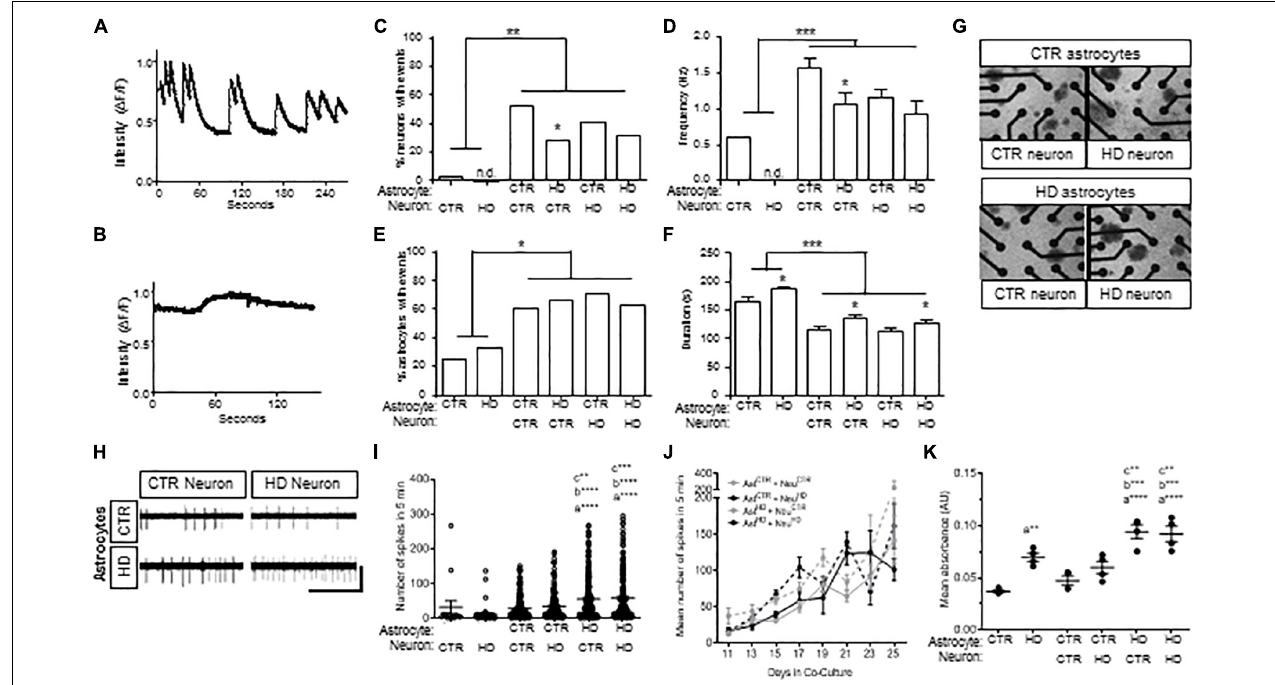
FIGURE 4 | Co-cultures of HD (HD109) and control (CTR33) astrocytes and neurons demonstrate alteration in neuronal firing at early time points and increased toxicity in response to glutamate. (A) Example traces of calcium events in control neurons with control astrocytes. (B) Example traces of calcium events in control astrocytes with control neurons. (C) Percentage of neurons with calcium events is higher in co-culture, but lower in HD astrocyte co-culture compared to control astrocyte co-culture. (D) Frequency of events is higher in neurons in co-culture compared to mono-culture, but less frequent in HD astrocyte co-culture compared to control astrocyte co-culture. (E) Percentage of astrocytes with calcium transients is greater in co-culture compared to mono-culture. (F) Astrocytes in mono-culture had longer transients than in co-culture, and HD astrocytes in mono-culture had longer transients than control astrocytes. Co-culture of control or HD neurons with HD astrocytes showed a longer duration of calcium transients compared to co-culture with control astrocytes. (G) Representative images of astrocyte and neuron co-cultures around the 16 electrodes (black circles) of a 48-well MEA plate. (H) Example electrode traces showing spikes detected from control (CTR) or HD neurons that are co-cultured with CTR or HD astrocytes. Scale bar: 12.5 µ V vertical by 5 s horizontal. (I) Spontaneous activity from control and HD co-cultures. Significance between conditions denoted as “a”: from Neu HD , “b”: from Neu CTR + Ast CTR , “c”: from Ast CTR + Neu HD . (J) No difference in total mean spike number per neuron in co-culture conditions during daily 5 min recordings over the course of 16 days. Data is presented as separated by the neuron co-culture (gray lines, control neurons; black lines, HD neurons), with solid lines representing control astrocytes and dashed lines indicating HD astrocytes. (K) Mean absorbance values of LDH activity in media after 12 h incubation with 100 µ M glutamate at 4 time points over 16 days. Significance between conditions denoted as “a”: from Ast CTR , “b”: from Ast CTR + Neur CTR , “c”: from Ast CTR + Neu HD . Ast, astrocyte; Neu, neuron; CTR, control. Calcium imaging: cells were analyzed from more than three separate experiments using a Chi squared test. MEA: activity was analyzed using Kruskal–Wallis ANOVA on ranks with Dunn’s method from three experiments with 8–66 neurons per condition at each time point. LDH, Analysis on data from triplicates measured at each of four time points across three experiments using one-way ANOVA with Bonferroni correction for multiple comparison ( ∗ p < 0.05, ∗∗ p < 0.01, ∗∗∗ p < 0.005, and ∗∗∗∗ p <